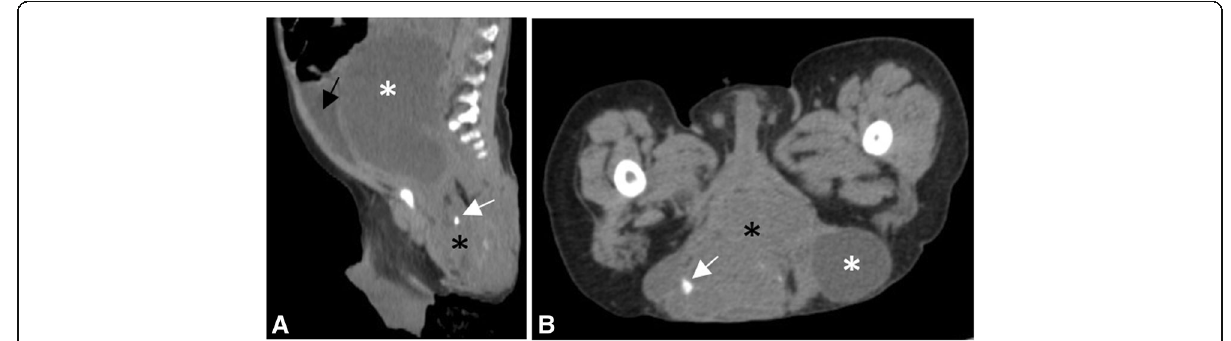
Fig. 1 Sagittal ( a ) and axial ( b ) unenhanced CT scan through the lower abdomen and pelvic region demonstrating a (10×8×4cm) complex mass lesion with solid (black asterisk) and cystic (white asterisk) components as well as specks of calcification (white arrow) arising from the sacro-coccygeal region extending intra-abdominally to the level of L2 vertebral body. This mass lesion is resulting in compression of the urinary bladder (black arrow) toward the anterior abdominal wall. The imaging features are suggestive of sacro-coccygeal teratoma type